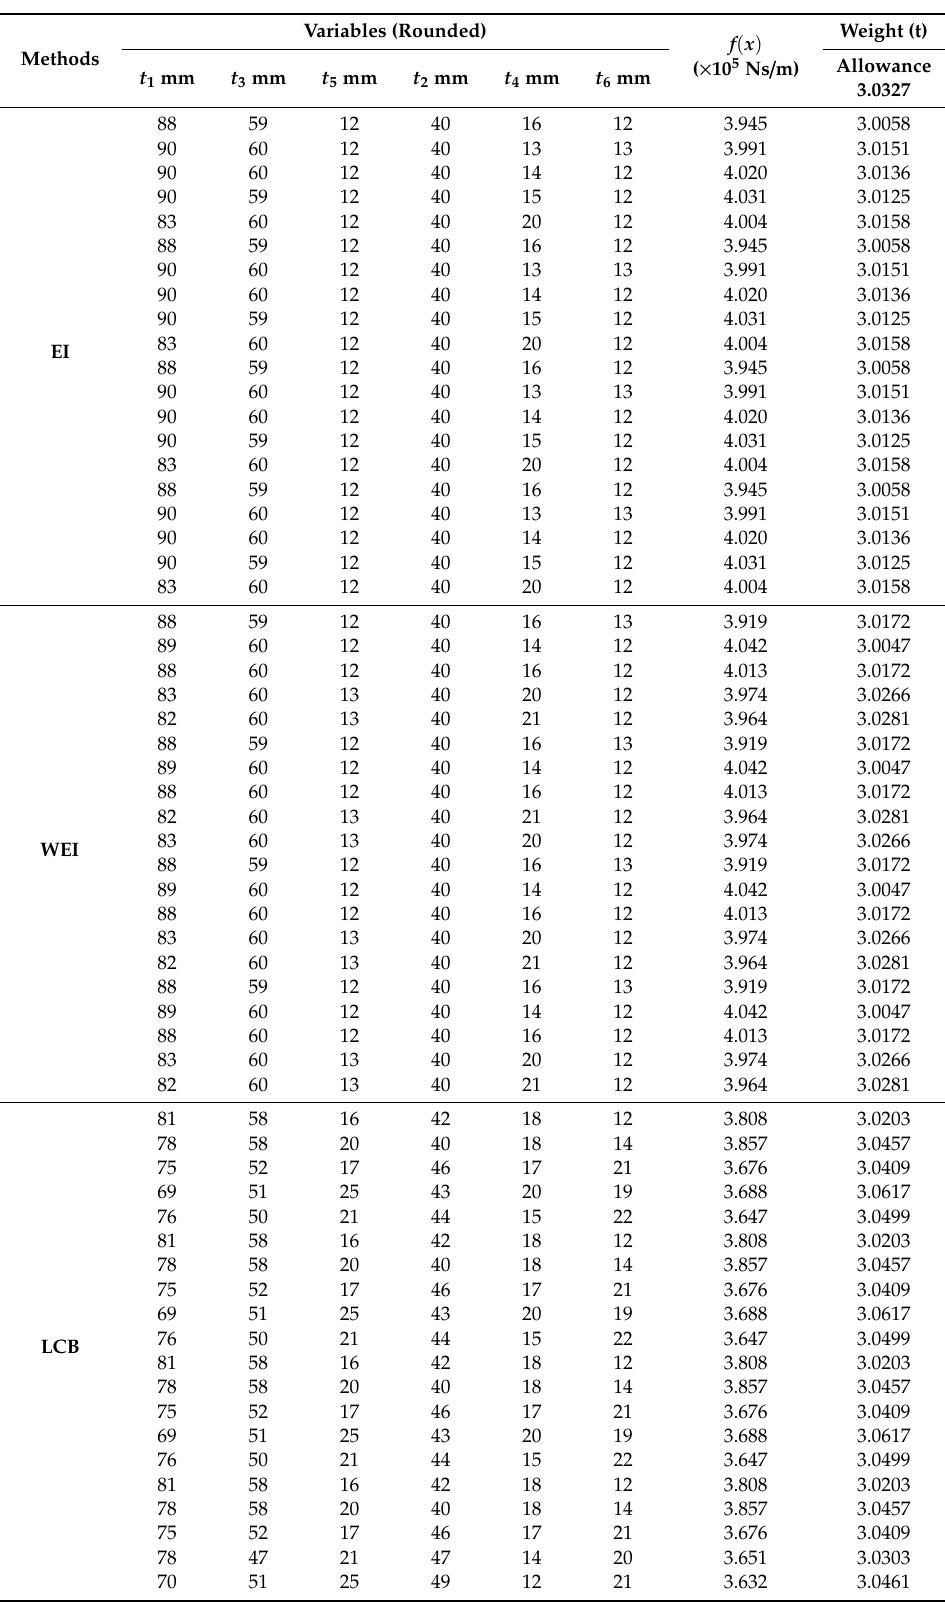
Table A1. Detailed optimization results of the engineering case with di ff erent